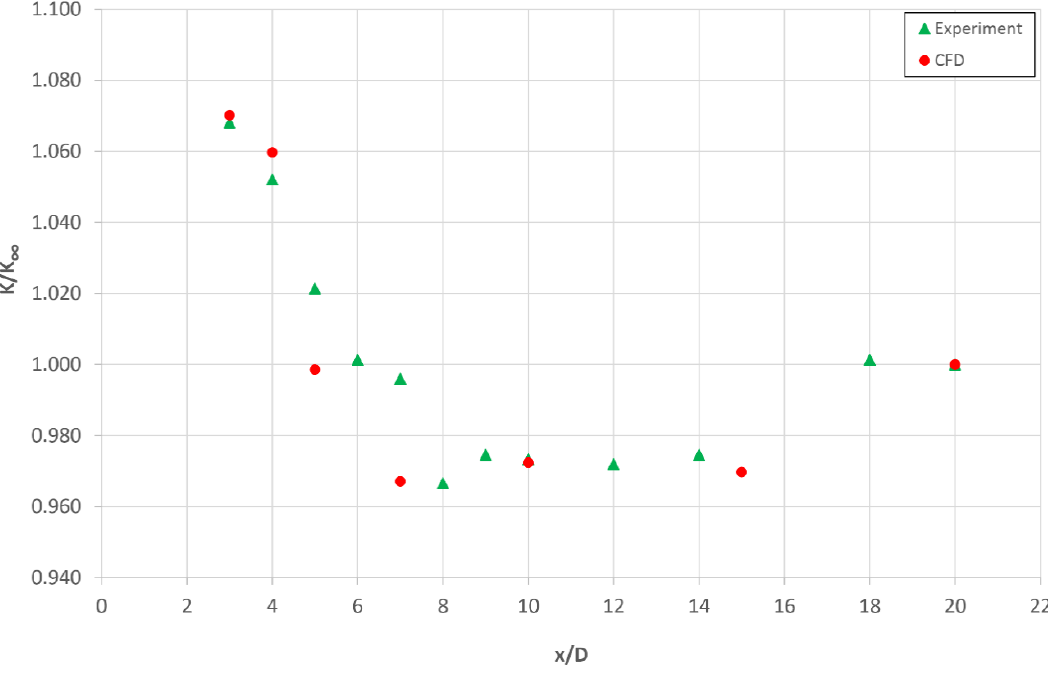
Figure 9. Relative value of the flow coefficient (K/K ∞ ) for the case of distortion formed by a single elbow 1-D and vertical position of the streamlined probe at mean velocity w = 18 m/s.